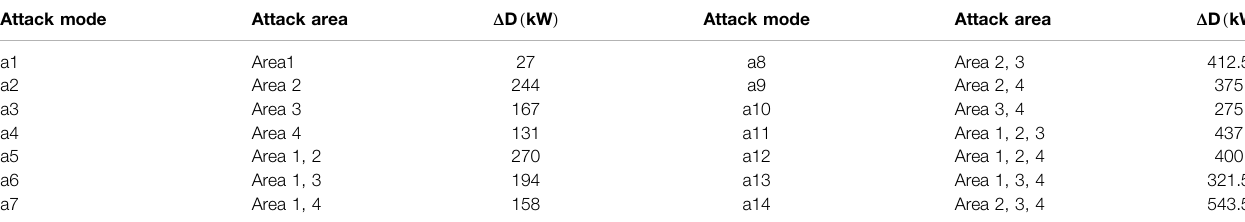
TABLE 4 | The load changes under various attack modes. Attack mode